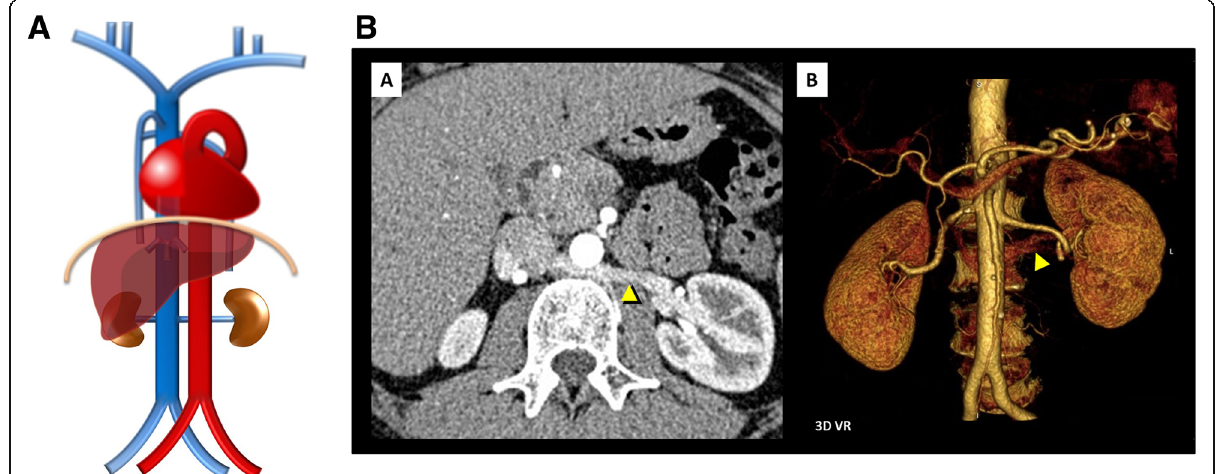
Fig. 11 a Retroaortic left renal vein schematic. Contrasting as there is a single renal vein passing dorsal to the aorta. b Retroaortic left renal vein. As shown on contrast-enhanced CT scan [A] and on volumetric 3D reconstruction